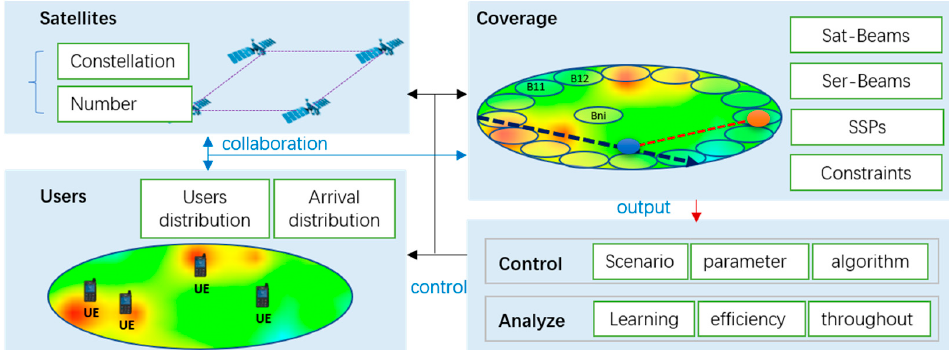
Figure 7. The simulation platform of load balancing for S-IoT-N.